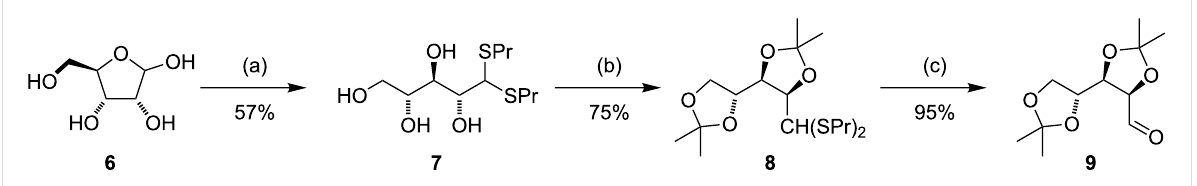
Scheme 2: Preparation of isopropylidene protected ribose 9 along a new, modified route. Reagents and conditions: (a) 2 equiv n- PrSH, conc. HCl/ H